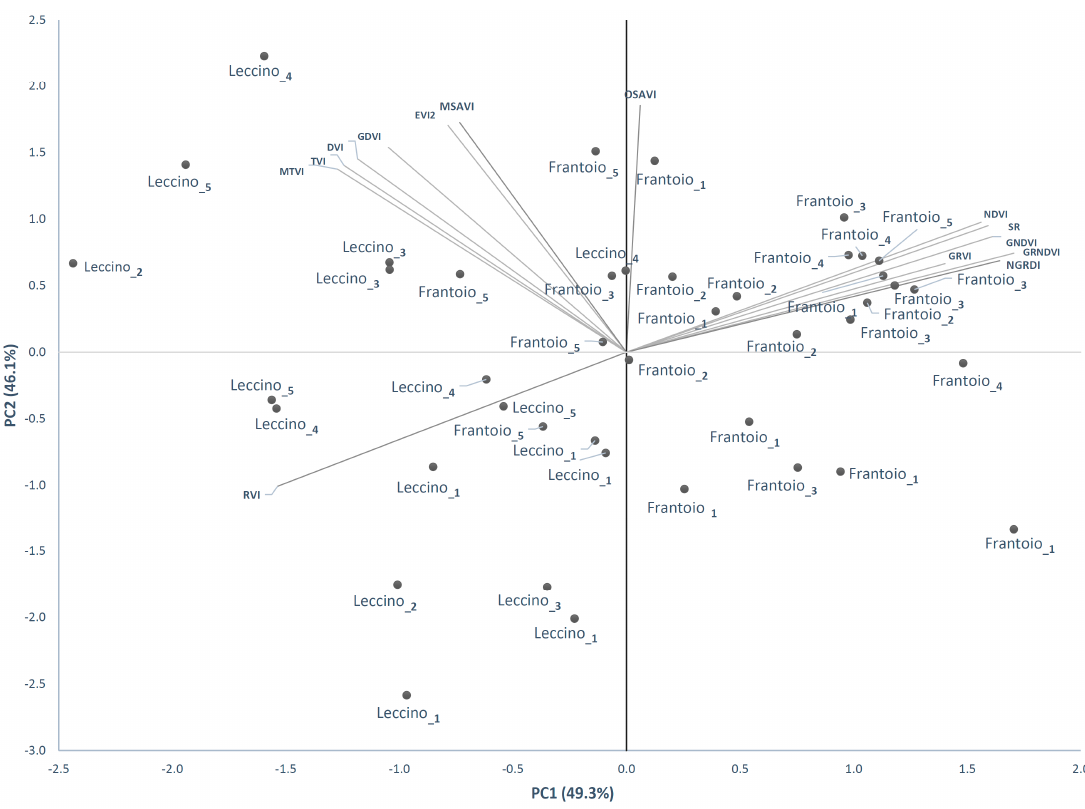
Figure 2. Principal component analysis (PCA) table between vegetation indices and different olive scion/rootstock combinations. Rootstocks: 1 = Carolea; 2 = Cipressino; 3 = Coratina; 4 = Frantoio; 5 = Leccino.